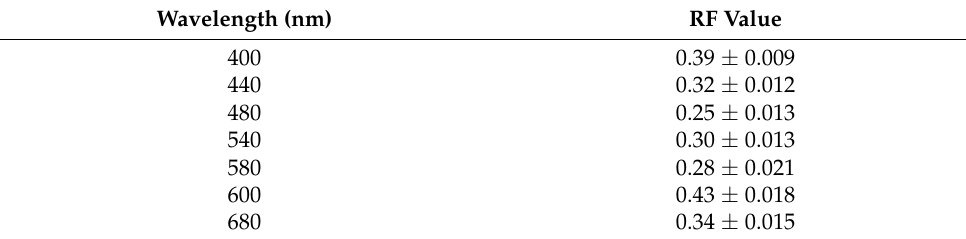
Table 3. RF values of various mono-color light